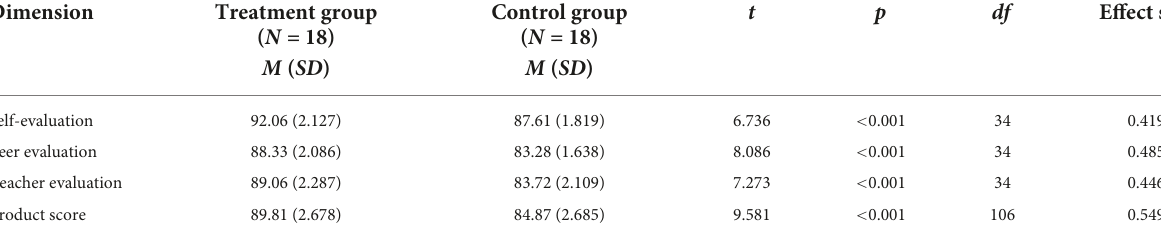
TABLE 2 Means and standard deviation of students’ project management skills in treatment group and control